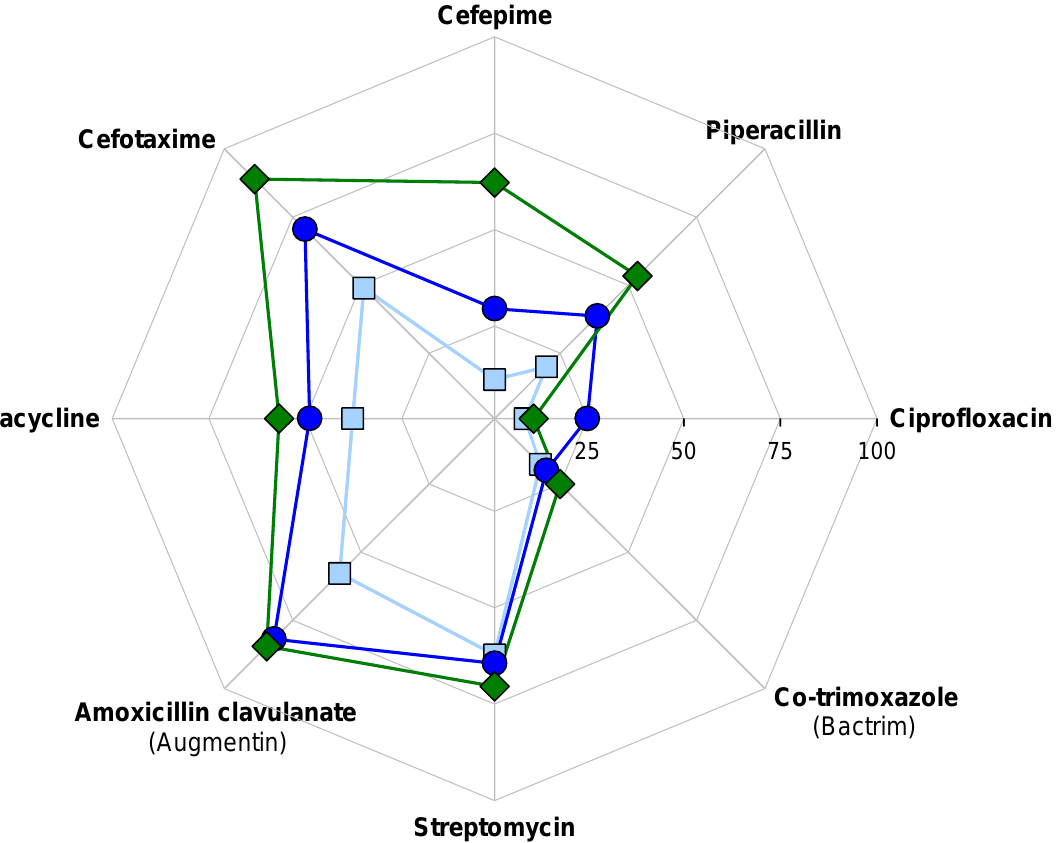
Figure 4. Fraction of isolates resistant to each antibiotic, with gray lines indicating 25 (innermost), 50, 75, and 100%. Samples were collected from the upstream site during clear weather (light blue squares), the CSO-impacted site during clear weather (dark blue circles), and the CSO-impacted site during an overflow event (green diamonds). Resistance to vancomycin (not shown) was 82% in all three samples.